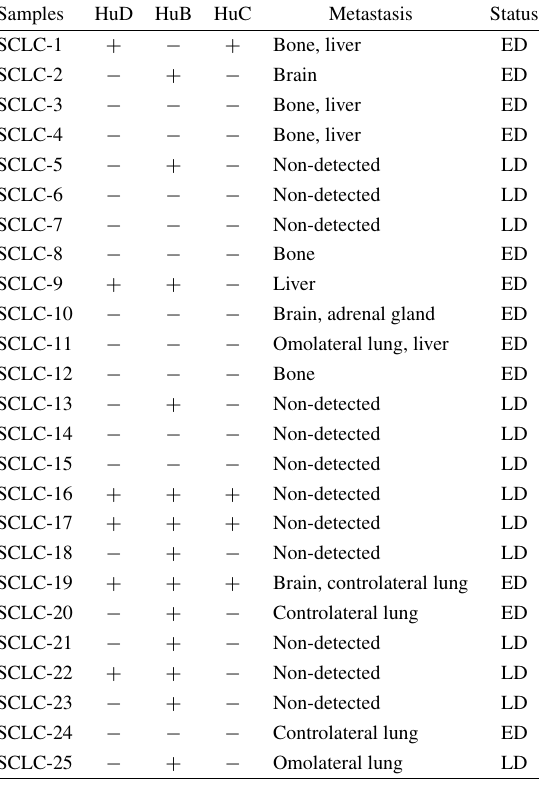
Correlation between patient characteristics and HuD, HuB and HuC positiveness of SCLC patients ( n =